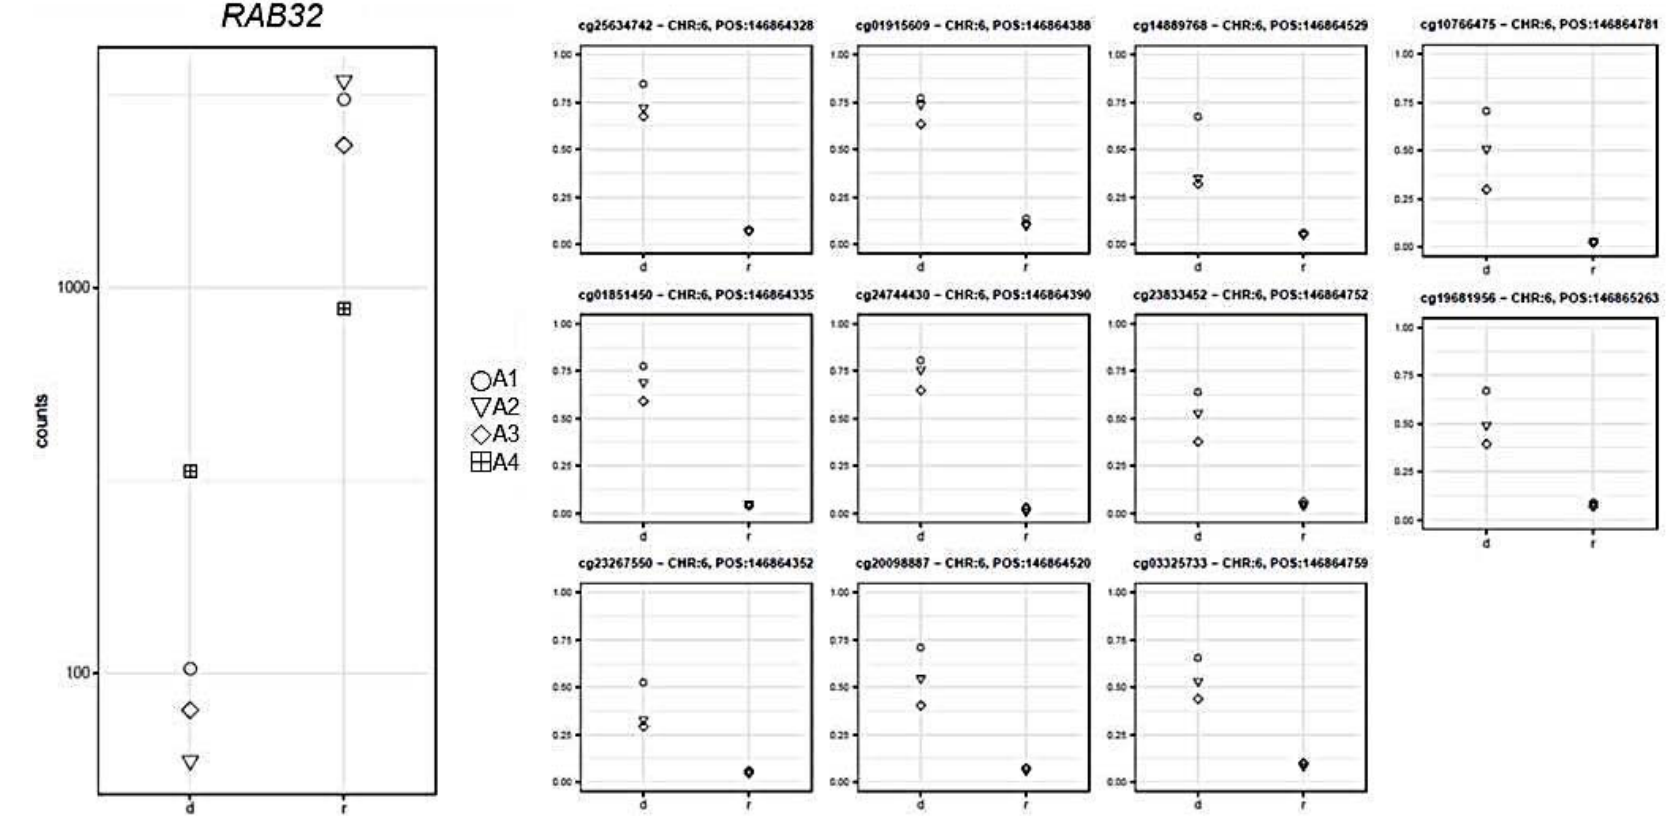
Figure 4. Gene expression (left panel) and corresponding methylation level ( y -axis, right panel) comparison between samples at diagnosis (d) and remission (r) for the RAB32 gene.